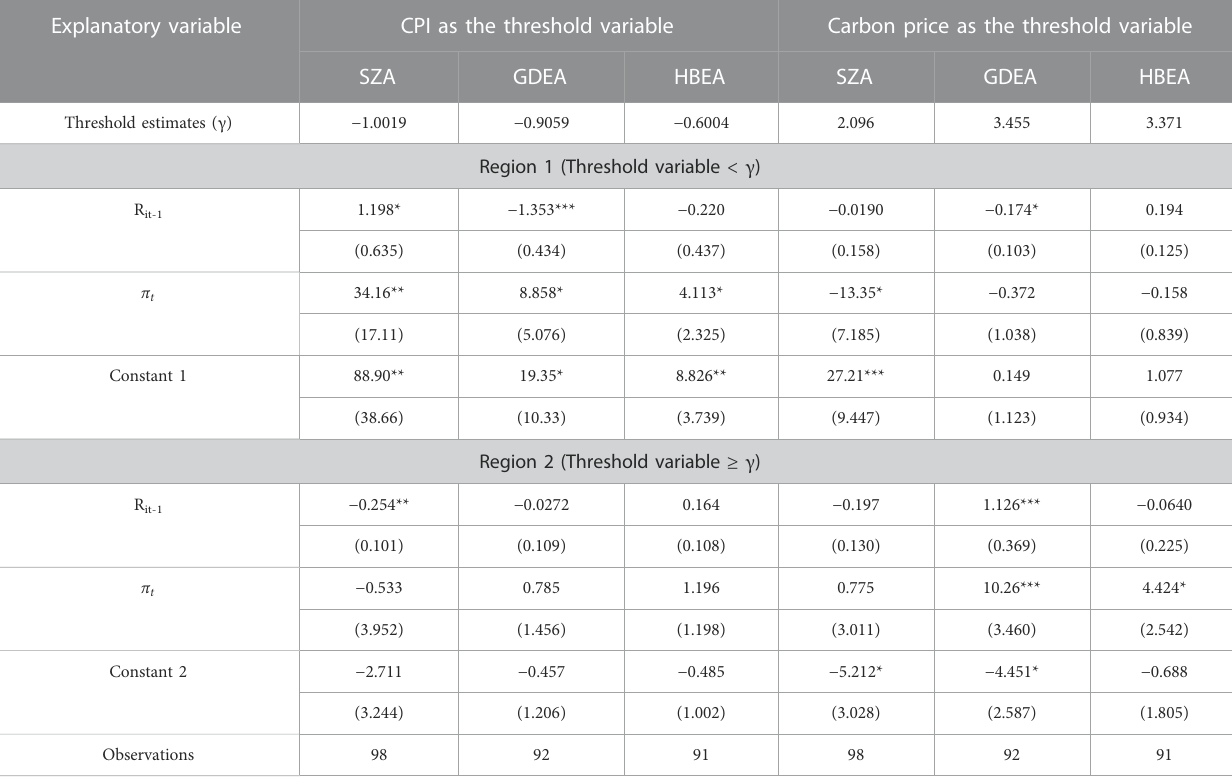
TABLE 3 Threshold regression results of carbon price growth rate and in fl ation rate.